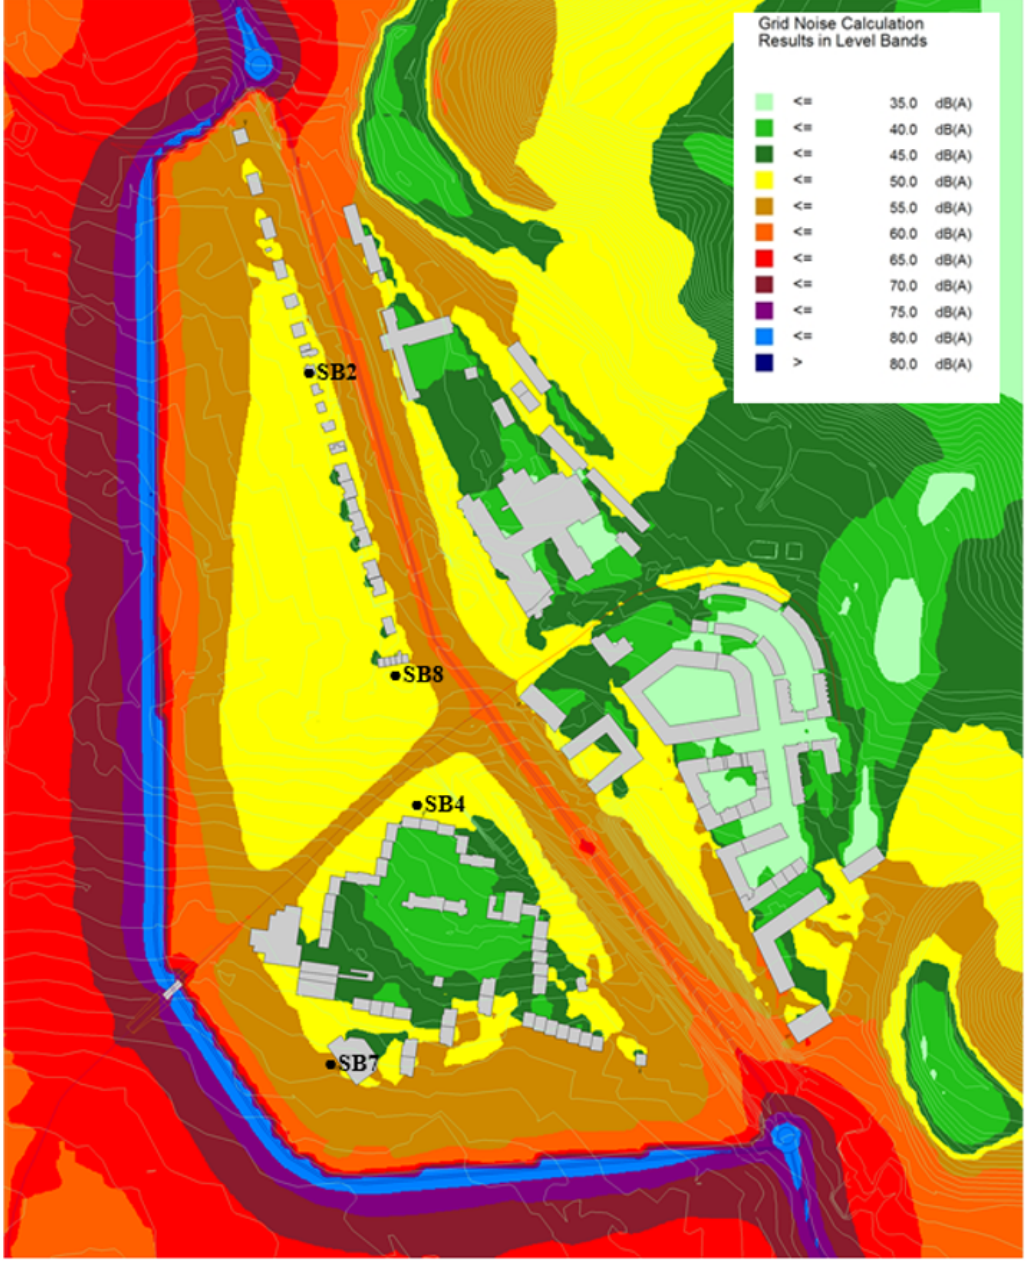
Figure 4: Calculated levels for a variant with the construction of a bypass - reference time interval – night